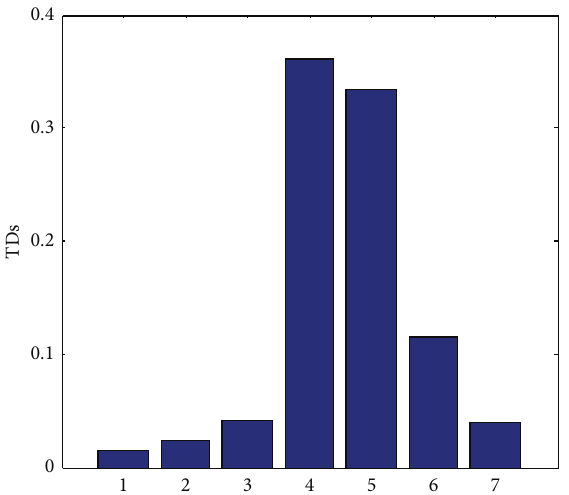
Figure 5: Detection indicators of the system with bilinear